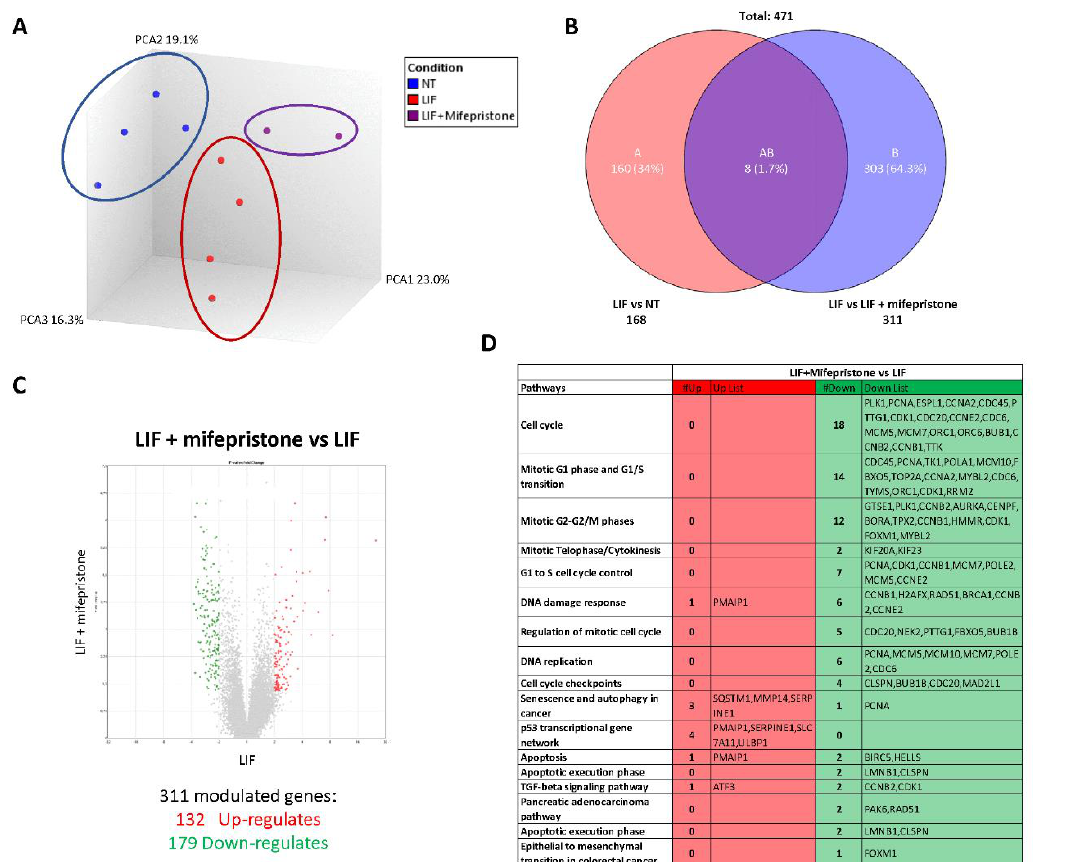
Figure 8. Analysis of mifepristone effects on MIA PaCa-2 cells challenged with LIF by RNAseq. ( A )